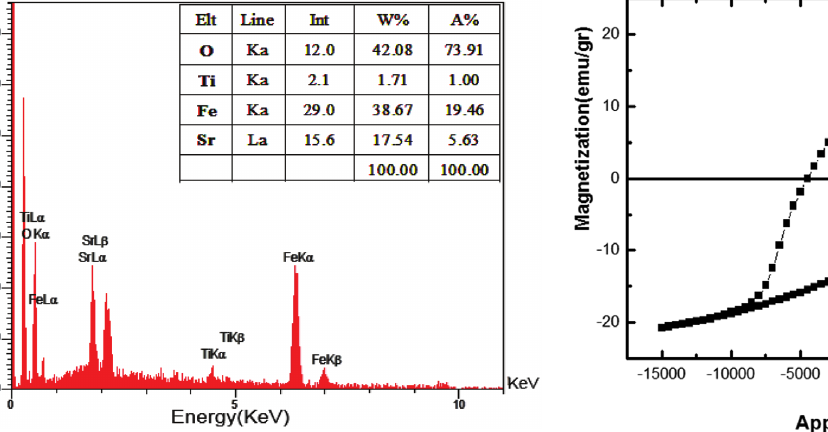
O –SrTiO . 12 19 3